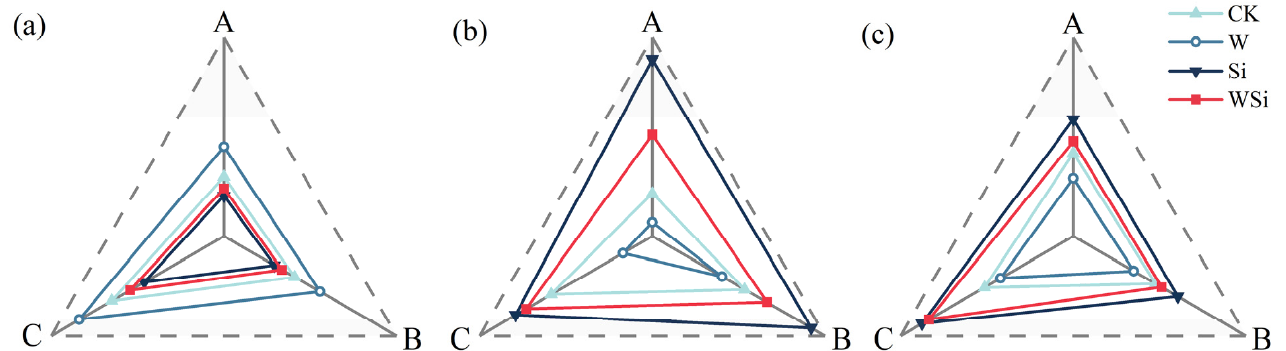
Figure 5. Radar plots of the synergistic effects of water management and silicon foliar spraying on MDA, SOD and POD contents in rice leaves (( a ) malondialdehyde (MDA); ( b ) superoxide dismutase (SOD); ( c ) peroxidase (POD)). A, B and C represent the actual measured Cd content in soil after the addition of exogenous Cd at 0.20 mg · kg − 1 , 0.60 mg · kg − 1 and 1.60 mg · kg − 1 ,